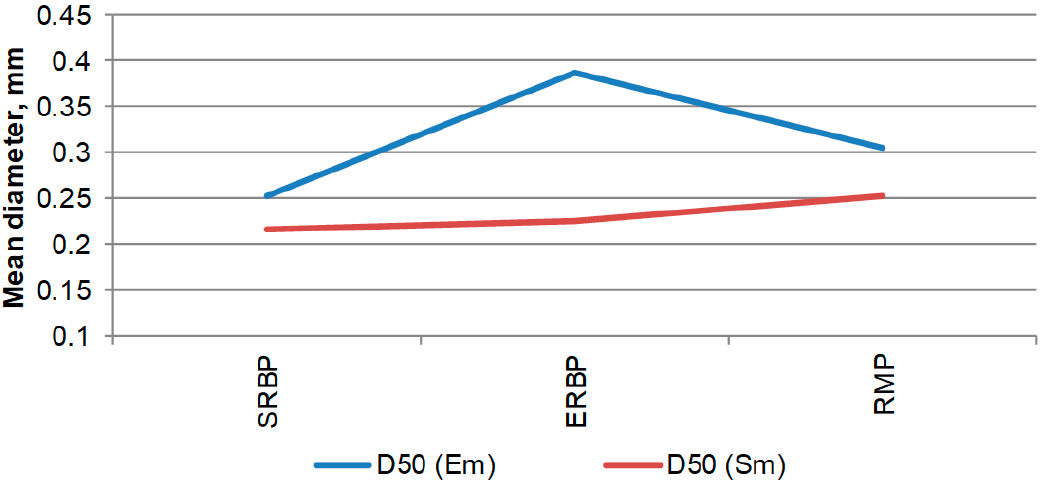
Figure 5. Emerged (Em) and submerged (Sm) mean diameter (D 50 ) of the sand samples for the SRBP, ERBP, and RMP types of reef flat profiles.